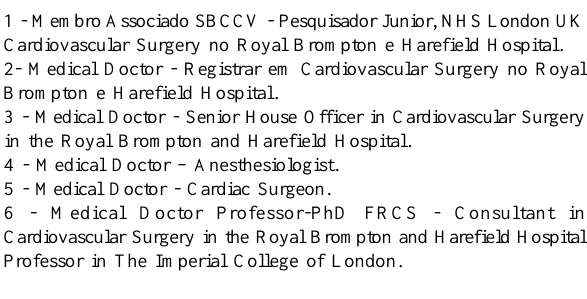
Resumo Objetivo: O propósito deste estudo é demonstrar que o reposicionamento do músculo papilar é uma técnica confiável para o reparo do prolapso da cúspide anterior, portanto, nós descrevemos esta técnica e seus resultados propondo-a como